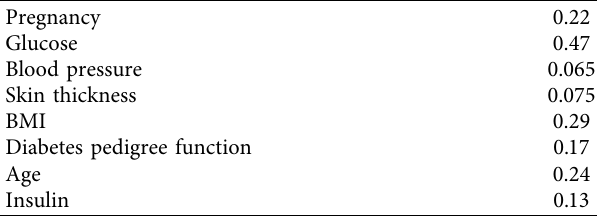
Figure 4: Correlation graph. Table 1: Correlation matrix